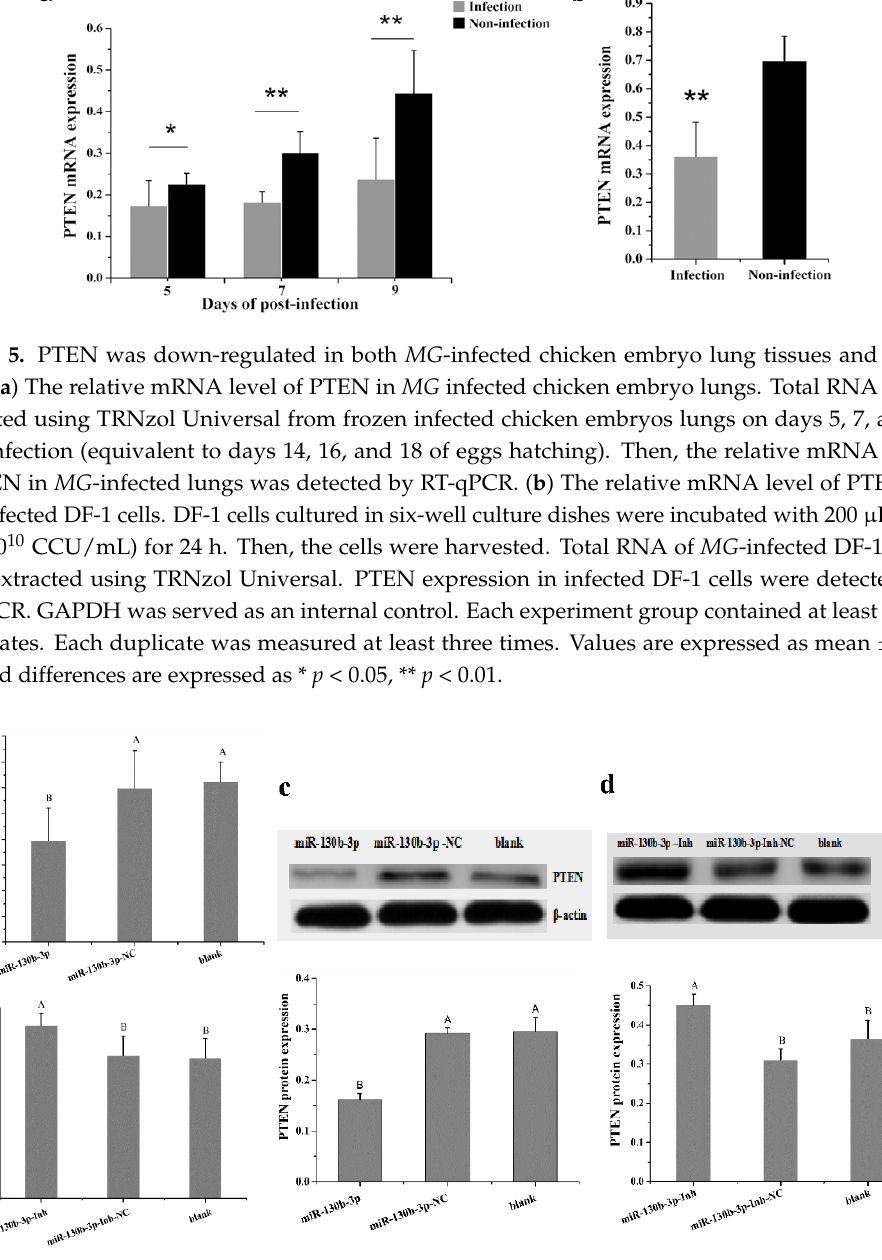
Figure 6. miR-130b-3p inversely regulated PTEN expression. ( a ) Overexpression of miR-130b-3p down-regulated PTEN mRNA expression in DF-1 cells. ( b ) Inhibitor of miR-130b-3p increased PTEN mRNA expression in DF-1 cells. ( c ) Overexpression of miR-130b-3p down-regulated PTEN protein expression in DF-1 cells. ( d ) Inhibitor of miR-130b-3p increased PTEN protein expression in DF-1 cells. Each experiment group contained at least three duplicates. Each duplicate was measured at least three times. Values are expressed as mean ± SD. Bars with different superscripts letters show marked differences ( p < 0.01).